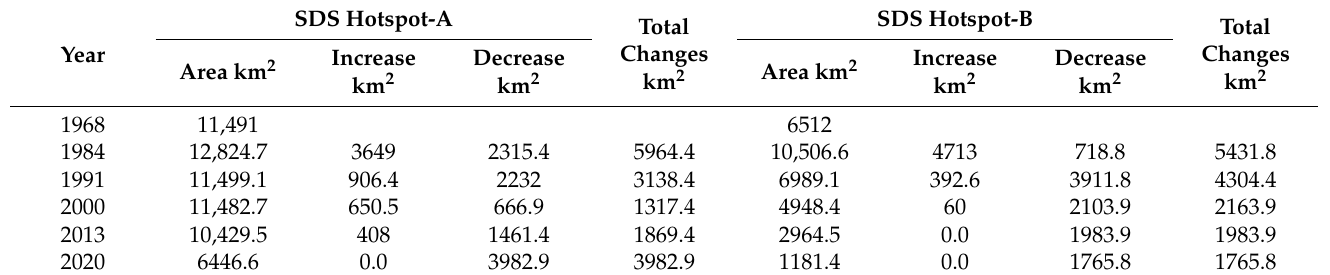
Table 3. Change in SDS source areas (increase and decrease) with time (1968, 1984, 1991, 2000, 2013, and 2020).